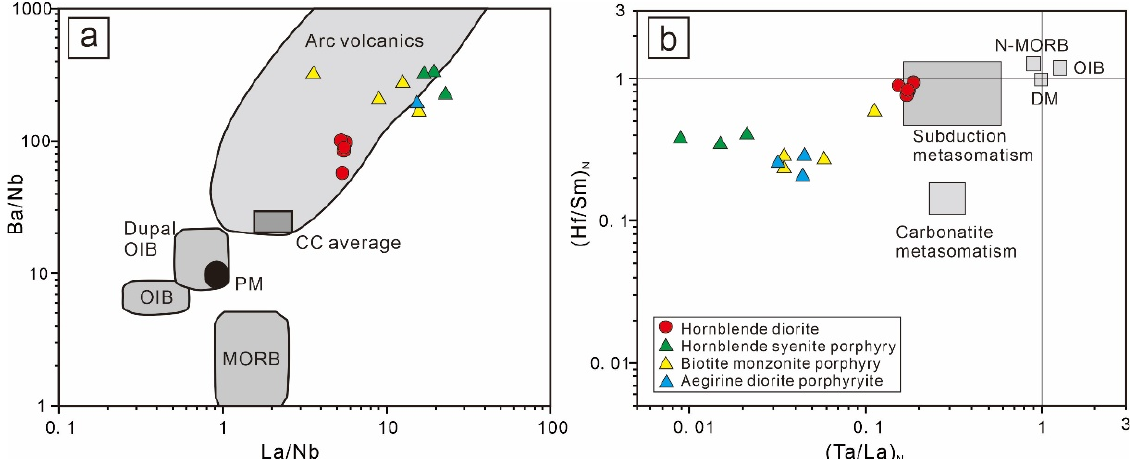
Figure 10. ( a ) Ba/Nb versus La/Nb diagram, modified after [73]. ( b ) (Ta/La) N versus (Hf/Sm) N dia- gram for the Longbaoshan alkaline complex, modified after [74]. CC = continental crust; OIB = ocean island basalts; PM = primitive mantle; MORB = mid-ocean-ridge basalt.